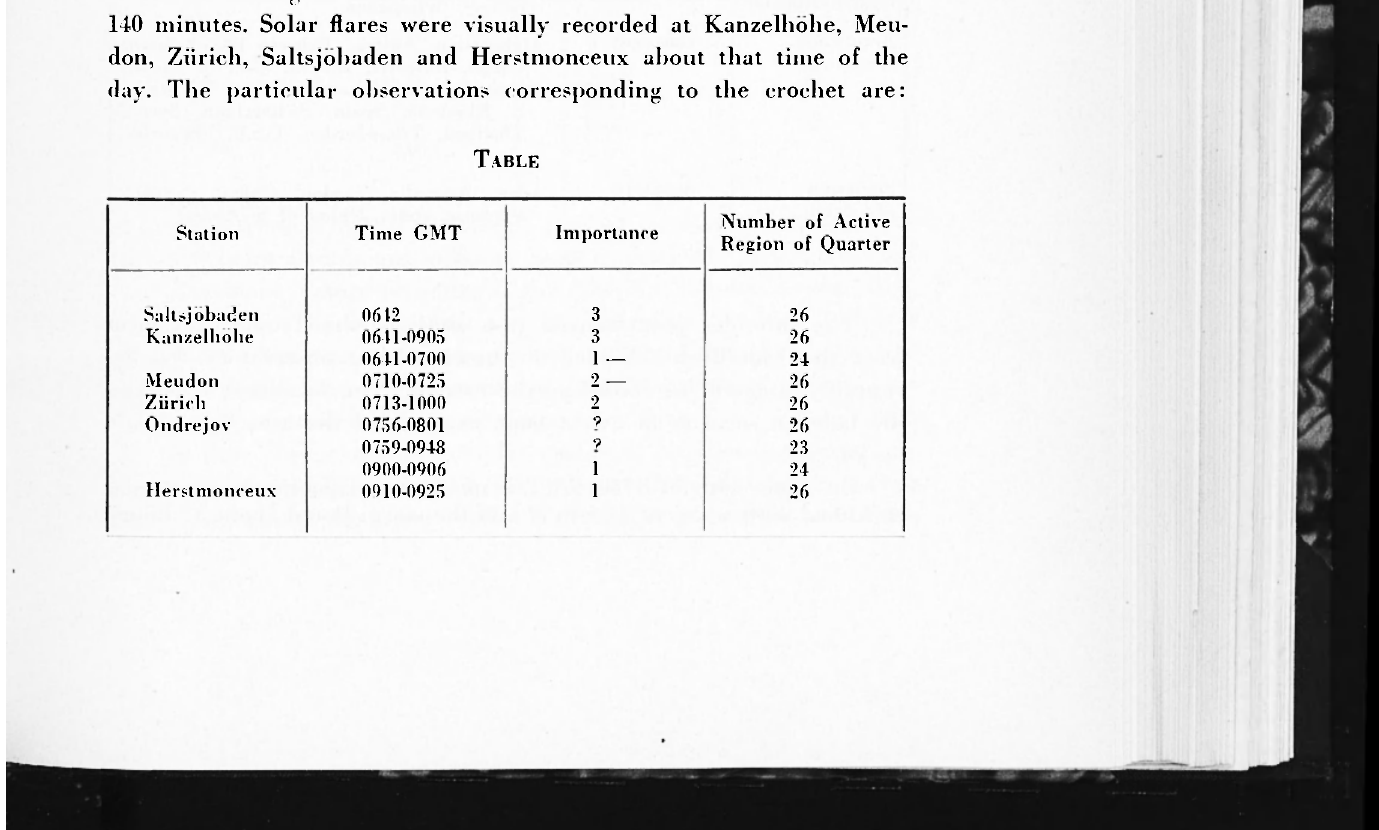
Station Time GMT Import ance